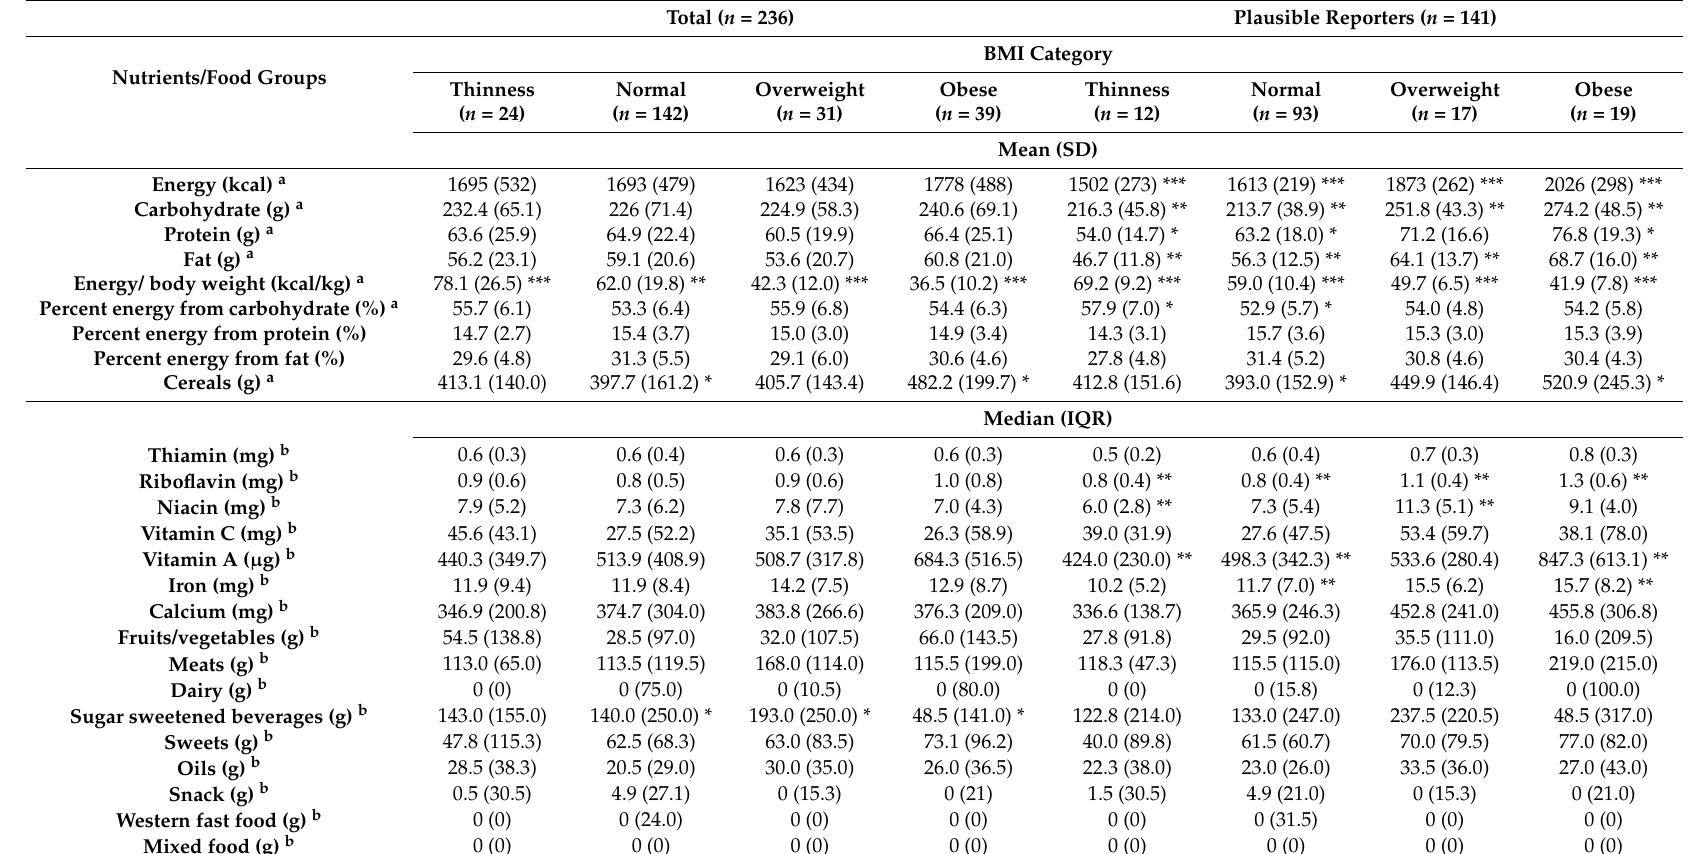
Table 3. Differences in dietary intakes by BMI category for all children and for plausible energy